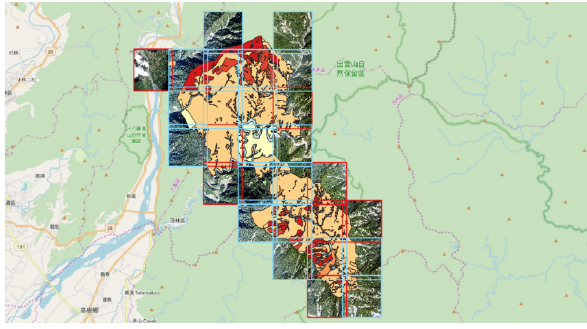
Figure 12. Landslide test data